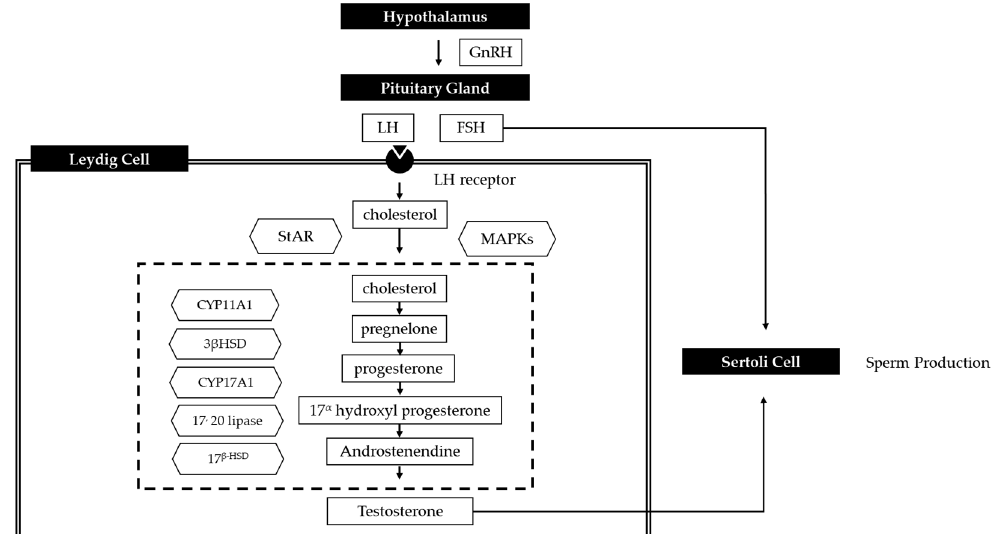
Figure 1. Male sex hormone formation. GnRH is secreted from the hypothalamus, subsequently LH stimulating the Leydig cell to produce testosterone and FSH activating the Sertoli cells to induce sperm production.